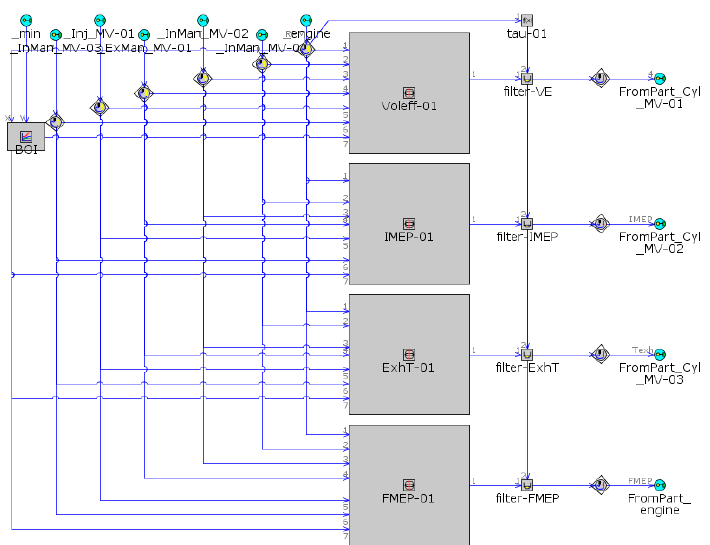
Figure 4. The proposed neural network that maps the mean value cylinder performance as a function of seven input variables in GT-SUITE.